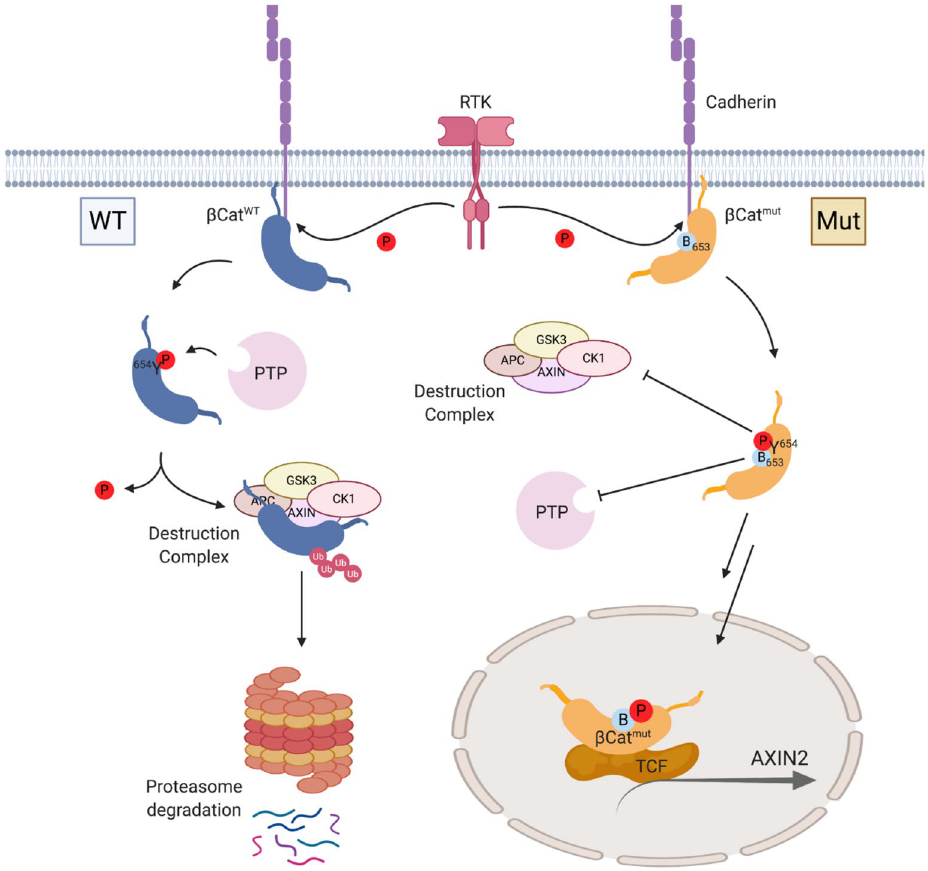
Figure 5. β-cat charge-mutation/PTP-restriction mechanism that enhances Wnt signaling. (Left) WT pY654 is dephosphorylated by PTPs and degraded. (Right) Basic mutants inhibit pY654 dephosphorylation. Sustained phosphorylation of β-cat reduces association with cadherins and leads to enhanced transcriptional co-activation with T-cell factor (TCF), revealed by the canonical target and negative regulator, AXIN2 . Schematic created with